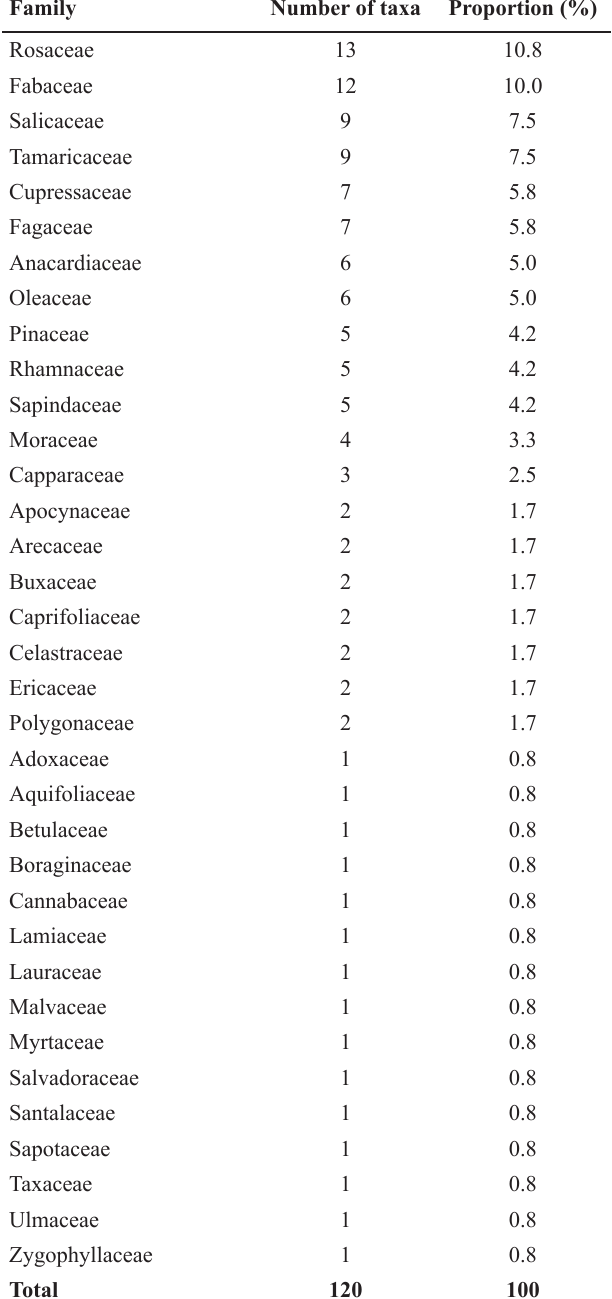
Table 2 – List of families and genera by number of taxa (n ≥ 2) in the tree flora of